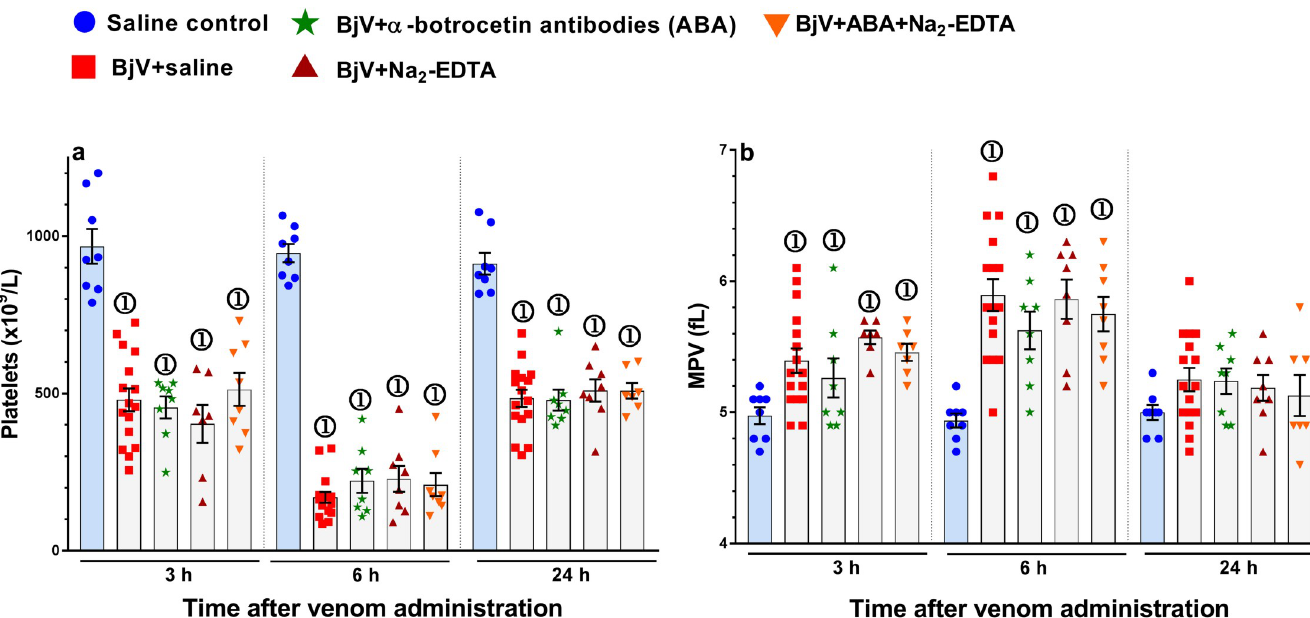
Fig 2. Platelet counts ( a ) and mean platelet volumes (MPV, b ) in rats 3, 6 and 24 h after BjV administration. Rats were injected with saline alone (saline control, blue bars), or BjV previously incubated with saline (BjV+saline), anti-botrocetin antibodies (ABA), BjV+Na 2 -EDTA, or BjV+ABA+Na 2 -EDTA. ① —Group statistically different (p < 0.05) from the saline control group at the respective time. Data are expressed as mean ± s.e.m (n = 6–16 rats/group per time period). https://doi.org/10.1371/journal.pntd.0009715.g002 PLOS NeglectedTropical Diseases | https://doi.org/10.1371/journal.pntd.0009715 September 3,